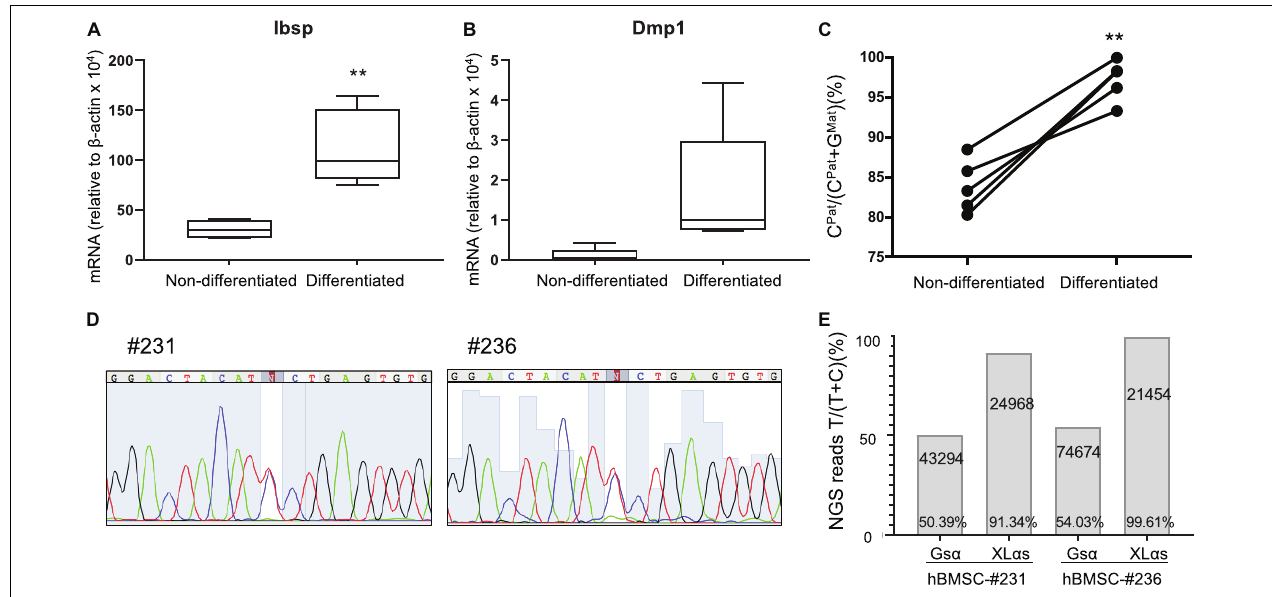
FIGURE 4 | Allele-specific XL α s expression becomes increasingly paternal with osteoblastic differentiation of BMSCs. The mRNA levels of osteoblast markers Ibsp (A) and Dmp1 (B) were measured to confirm osteoblastic differentiation of BMSCs. qRT-PCR was used with β -actin as reference control. ** p < 0.01 vs. non-differentiated by two-tailed Student’s t -test ( n = 5). (C) Percent of C-containing (paternal) NGS reads in XL α s RT-PCR amplicons before and after differentiation toward the osteoblast lineage. Data are from individual F1 intercrosses of C57BL/6 × 129/Sv. ** p < 0.01 vs. non-differentiated by paired Student’s t -test. (D) Sanger sequencing traces showing the heterozygous GNAS exon 5 C-to-T polymorphism in two separate human BMSC (hBMSC) samples. (E) Percentage of T-containing reads relative to total reads obtained from the NGS of Gs α and XL α s RT-PCR products. The total number of NGS reads for each amplicon is indicated. T-containing reads for #231-Gs α : 4017 (forward), 17727 (reverse); #231-XL α s: 1179 (forward), 21533 (reverse); #236-Gs α : 6522 (forward), 33294 (reverse); #236-XL α s: 922 (forward), and 20448